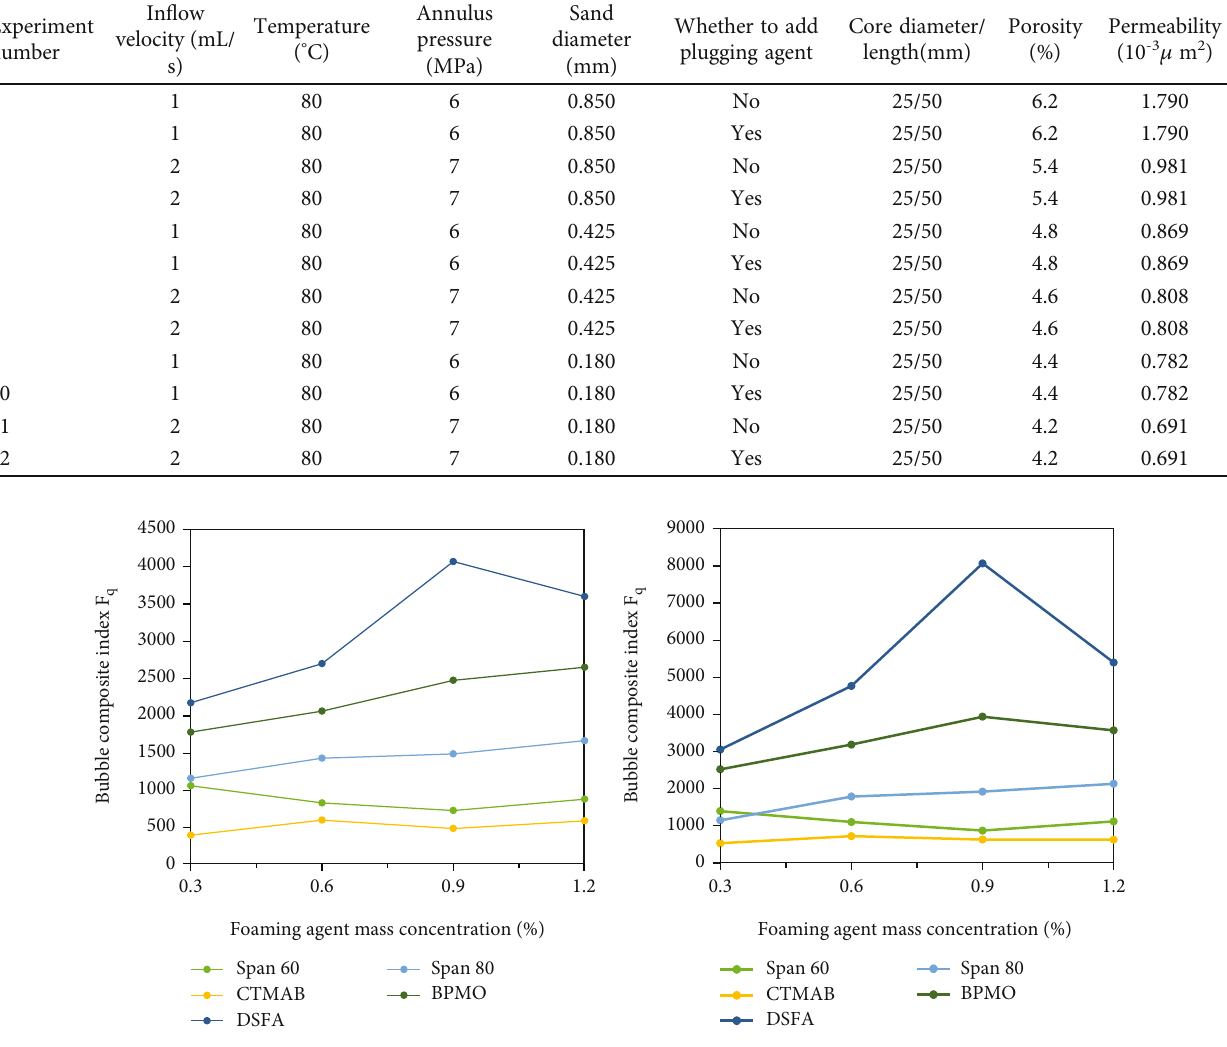
Table 1: Experimental parameters.